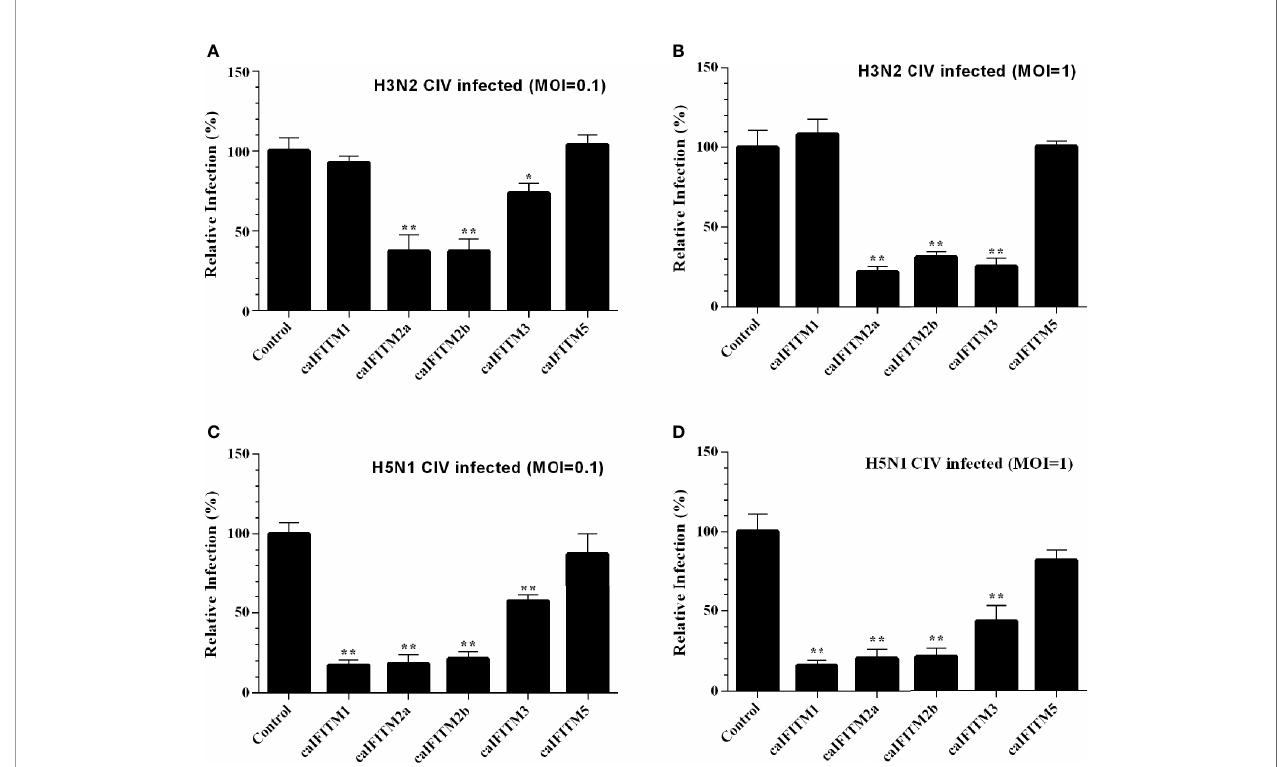
FIGURE 7 | Antiviralactivity of caIFITMsagainst CIV. A549 cells stably expressing caIFITMs were infected with H3N2 CIV (GD/2014) (A,B) andH5N1 CIV (GD/2013) (C, D) at 0.1 and 1 MOI. At 24 hpi,the cellculture supernatant was collected andusedfor RNA extraction.The expression level ofCIV M gene was determinedby RT-qPCR and was used for estimating the virustiter incell culture supernatant. The virus titer of CIVharvested inA549 cells stably expressing caIFITMs was compared with the uninfected cellgroup. Alldata represent the meansand SD for experiments (each repeatedin triplicate) andwere analyzed byStudent ’ s t -test. (* p < 0.05; ** p <